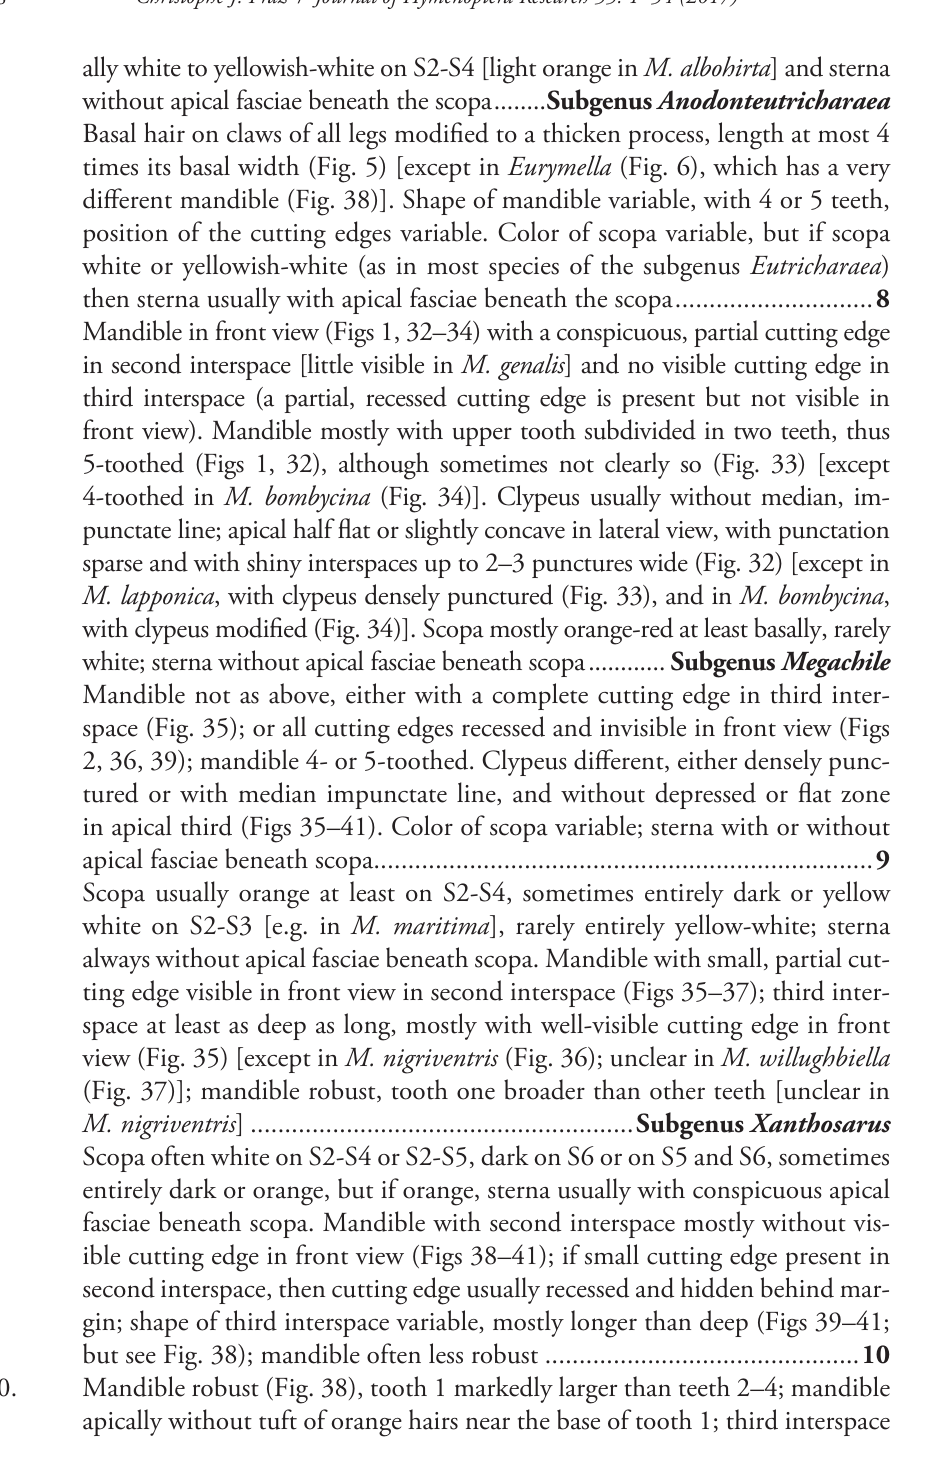
ally white to yellowish-white on S2-S4 [light orange in M. albohirta ] and sterna without apical fasciae beneath the scopa ........ Subgenus Anodonteutricharaea – Basal hair on claws of all legs modified to a thicken process, length at most 4 times its basal width (Fig. 5) [except in Eurymella (Fig. 6), which has a very different mandible (Fig. 38)]. Shape of mandible variable, with 4 or 5 teeth, position of the cutting edges variable. Color of scopa variable, but if scopa white or yellowish-white (as in most species of the subgenus Eutricharaea ) then sterna usually with apical fasciae beneath the scopa ............................. 8 8 Mandible in front view (Figs 1, 32–34) with a conspicuous, partial cutting edge in second interspace [little visible in M. genalis ] and no visible cutting edge in third interspace (a partial, recessed cutting edge is present but not visible in front view). Mandible mostly with upper tooth subdivided in two teeth, thus 5-toothed (Figs 1, 32), although sometimes not clearly so (Fig. 33) [except 4-toothed in M. bombycina (Fig. 34)]. Clypeus usually without median, im- punctate line; apical half flat or slightly concave in lateral view, with punctation sparse and with shiny interspaces up to 2–3 punctures wide (Fig. 32) [except in M. lapponica , with clypeus densely punctured (Fig. 33), and in M. bombycina , with clypeus modified (Fig. 34)]. Scopa mostly orange-red at least basally, rarely white; sterna without apical fasciae beneath scopa ............ Subgenus Megachile – Mandible not as above, either with a complete cutting edge in third inter- space (Fig. 35); or all cutting edges recessed and invisible in front view (Figs 2, 36, 39); mandible 4- or 5-toothed. Clypeus different, either densely punc- tured or with median impunctate line, and without depressed or flat zone in apical third (Figs 35–41). Color of scopa variable; sterna with or without apical fasciae beneath scopa ......................................................................... 9 Scopa usually orange at least on S2-S4, sometimes entirely dark or yellow white on S2-S3 [e.g. in M. maritima ], rarely entirely yellow-white; sterna always without apical fasciae beneath scopa. Mandible with small, partial cut- ting edge visible in front view in second interspace (Figs 35–37); third inter- space at least as deep as long, mostly with well-visible cutting edge in front view (Fig. 35) [except in M. nigriventris (Fig. 36); unclear in M. willughbiella (Fig. 37)]; mandible robust, tooth one broader than other teeth [unclear in M. nigriventris ] ........................................................ Subgenus Xanthosarus – Scopa often white on S2-S4 or S2-S5, dark on S6 or on S5 and S6, sometimes entirely dark or orange, but if orange, sterna usually with conspicuous apical fasciae beneath scopa. Mandible with second interspace mostly without vis- ible cutting edge in front view (Figs 38–41); if small cutting edge present in second interspace, then cutting edge usually recessed and hidden behind mar- gin; shape of third interspace variable, mostly longer than deep (Figs 39–41; but see Fig. 38); mandible often less robust .............................................. 10 10. Mandible robust (Fig. 38), tooth 1 markedly larger than teeth 2–4; mandible apically without tuft of orange hairs near the base of tooth 1; third